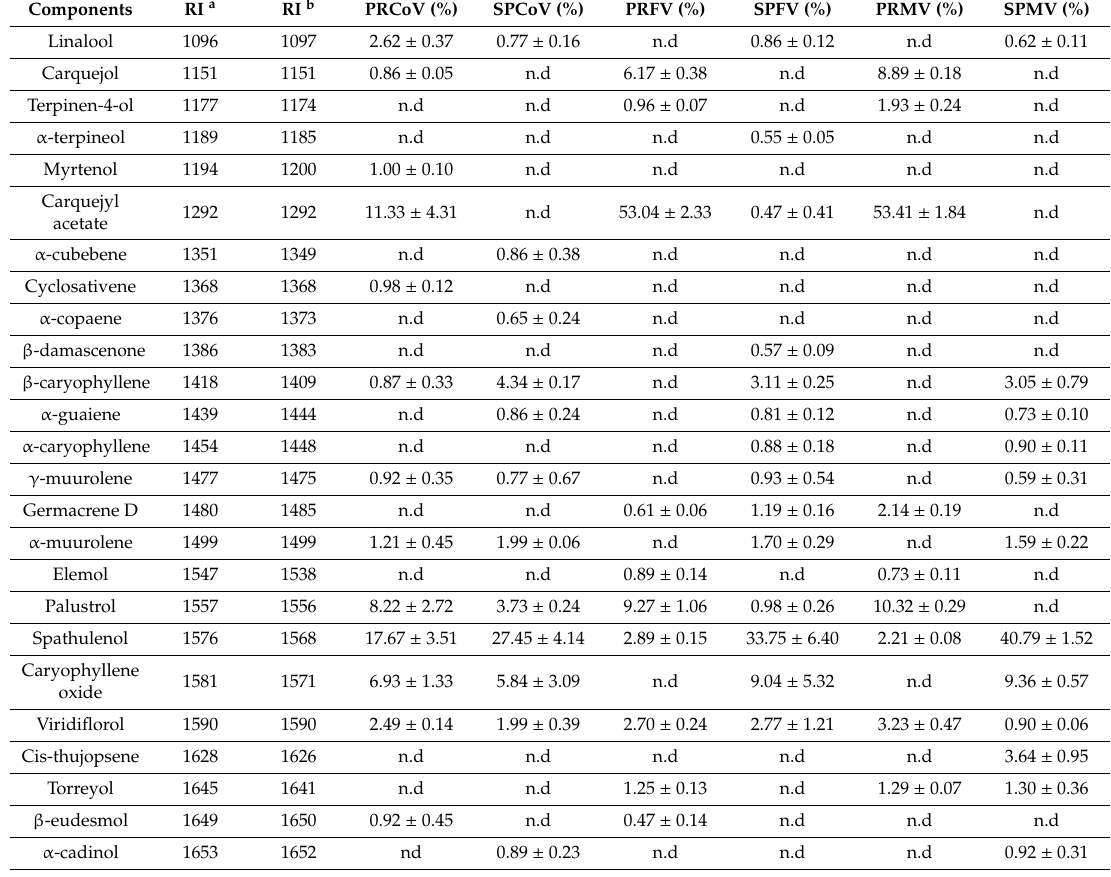
Table 1. Relative composition of the identified components in the analyses of the essential from B. myriocephala and B. trimera